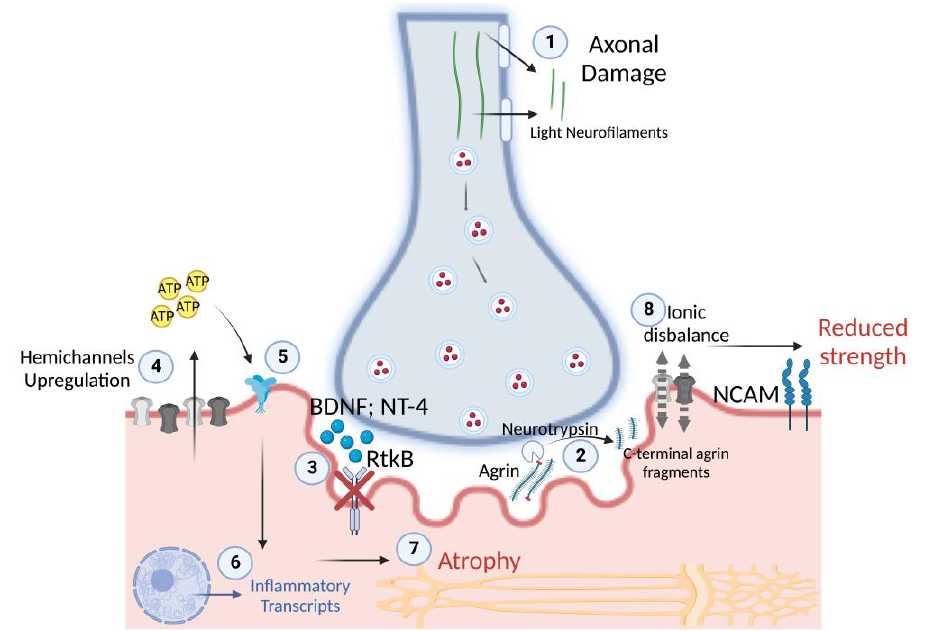
Figure 10. Overview of the potential physiological mechanisms during the early stages of disuse in humans. (1) After 5 days of disuse, the release of light neurofilaments suggests axonal damage, which may progressively cause NMJ instability (2) through the cleavage of agrin and the expression of NCAM, which show significance at 10 days of disuse. NMJ instability is associated with (3) reduced RtkB neurotrophin receptors for BDNF and NT-4, (4) which may be responsible for the marked sarcolemmal hemichannels ’ upregulation after 10 days of disuse. In turn, hemichannels may start to release ATP with paracrine properties, (5) acting on purinergic receptors, (6) resulting in the transcription of inflammatory transcripts and (7) in muscle atrophy, with the progression of disuse. Indeed, (8) sarcolemmal hemichannels upregulation may cause ionic disbalance along the sarcolemma, resulting in unstable membrane potential at rest and a reduced capacity to generate efficacious excitation – contraction coupling cascades, resulting in reduced muscle strength.